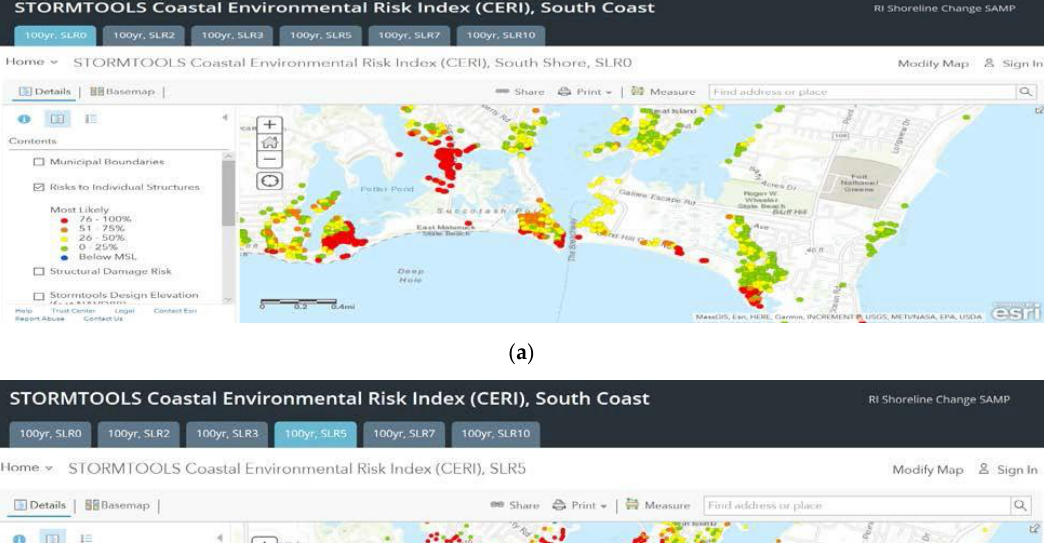
Table 4. Number of structures, by prototype class, impacted by the 100 yr storm surge with SLR values from